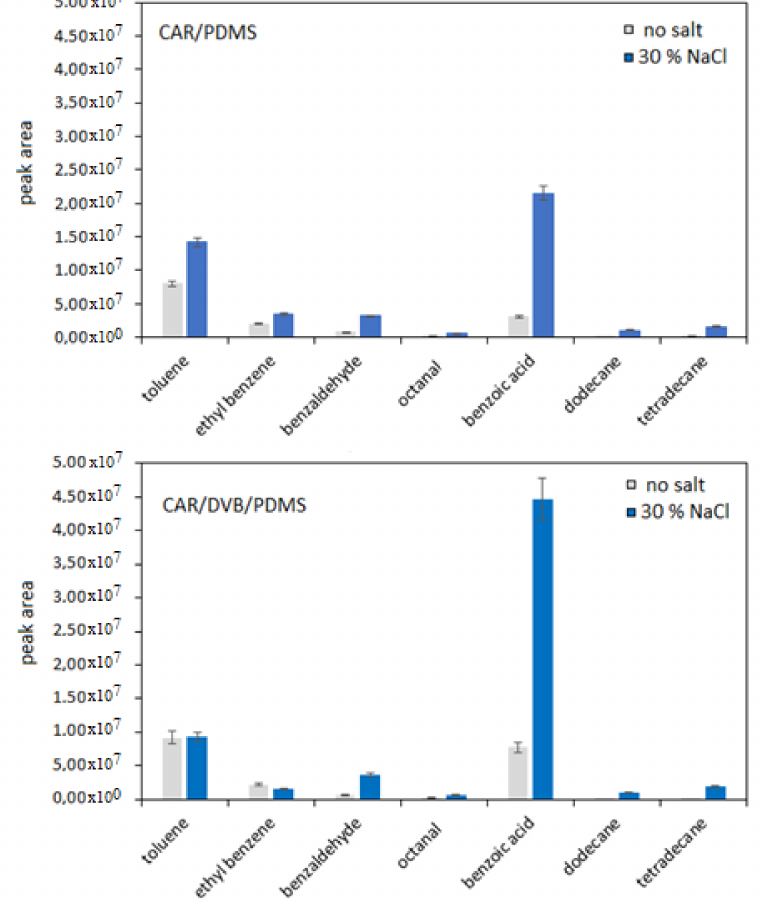
Figure 3. Effect of the NaCl concentration on the DI extraction efficiency obtained with both se- lected